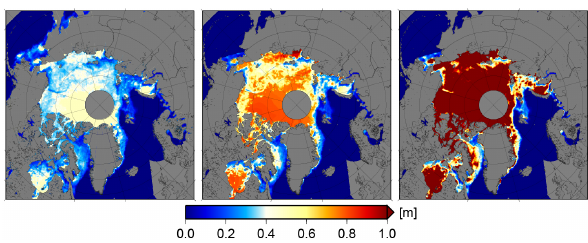
Figure 14. SMOS ice thickness derived from retrieval algorithm I, II, and II* in the Arctic on 1 February